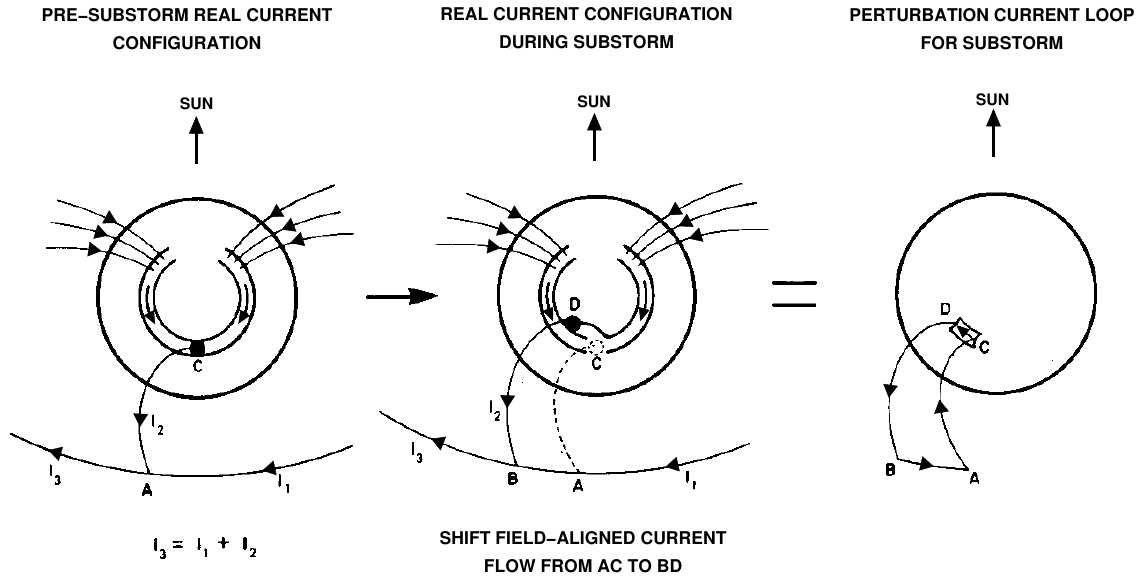
Fig. 2. Schematic showing the development of a substorm in terms of the change of current flow at substorm expansive phase onset. The unbalanced portion of the field-aligned currents is shown in this diagram together with the ionospheric eastward and westward directly driven electrojets. The magnetic perturbation pattern of the expansive phase can be explained by a westward jump of a pre-existing region of upward FAC flow and the associated westward expansion of the westward electrojet (after Rostoker, 1974).